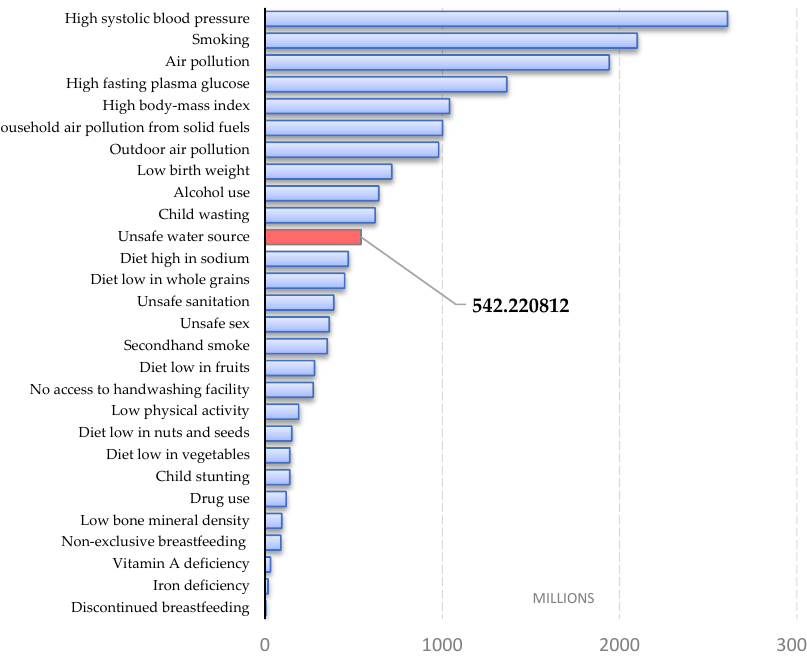
Figure 1. Estimated number of deaths with causes from 1990–2019, Data from, Institute for Health Metrics and Evaluation, the Global Burden of Disease (GBD) study 2019 (available at: http://ghdx.healthdata.org/gbd-results-tool accessed on 8 May 2022).